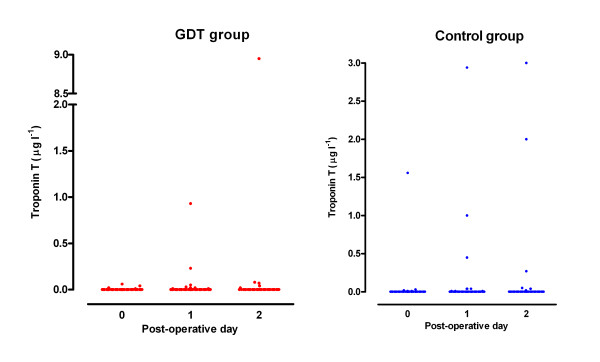
Post-operative troponin T measurements in patients randomised to the Control and Goal Directed Therapy (GDT) groups.